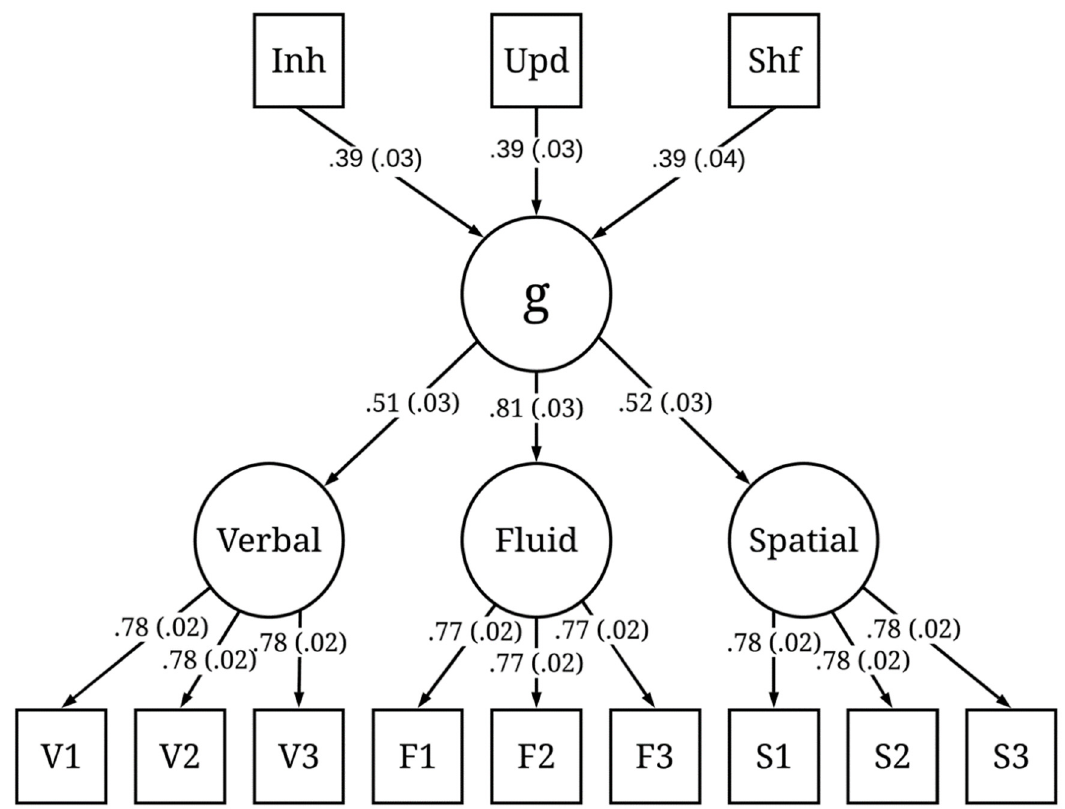
Figure 2. Latent variable model of intelligence and executive attention processes based on 200 iterations of simulated test scores. Values represent the mean (and standard deviation) standardized factor loadings. Inh = inhibition; Upd = updating; Shf = shifting.